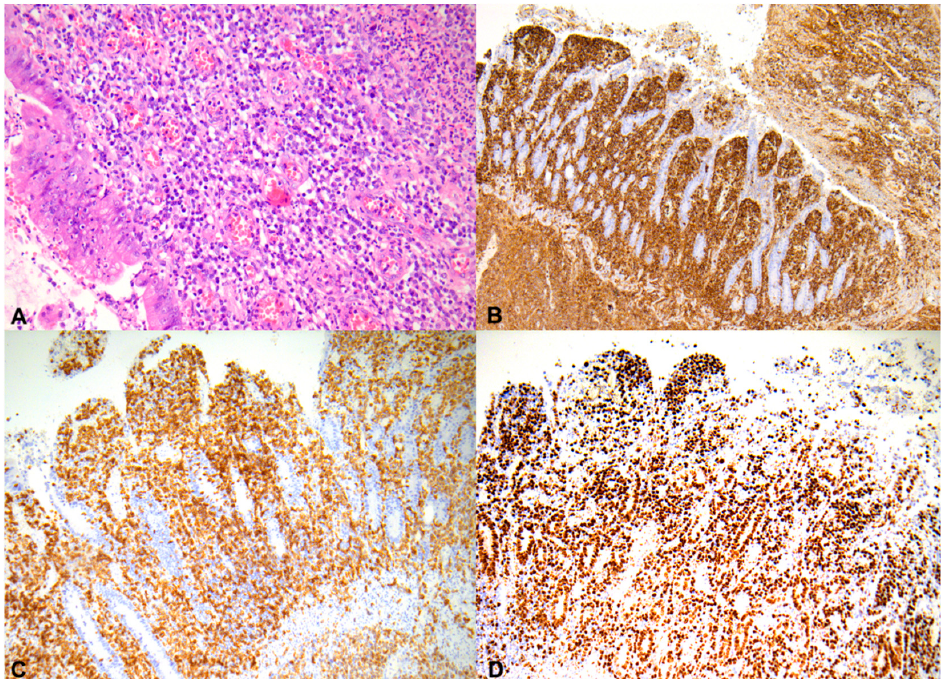
Figure 2. Neoplastic cells infiltrate the entire thickness of the small intestine, H&E, 200× ( A ); these neoplastic cells are strongly and diffusely positive for CD45, 50× ( B ); neoplastic lymphocyte showing dimmed, diffuse nuclear staining for CD3, 100× ( C ); tumor cells showing a high proliferation index (Ki-67 < 70%), 100× ( D ). The autopsy also showed the presence of lymphoma in the mesentery of the small intestine, uterus, cecum, lung, and mediastinal lymph nodes. The lymphoma was CD45, CD3, CD7, CD43, CD4, CD30, and Ki-67 positive. The first histopathological study de- scribed enteropathy-associated T-cell lymphoma (EATL) according to the WHO classifi- cation. Based on further histopathological consultations, the lymphoma was classified as peripheral T-cell lymphoma not otherwise specified (PTCL-NOS). (Figure 3).